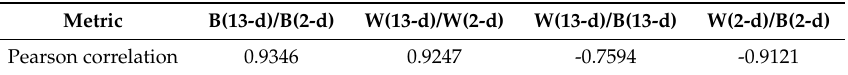
Table 8. Pearson correlation between the reconstructed equaliser